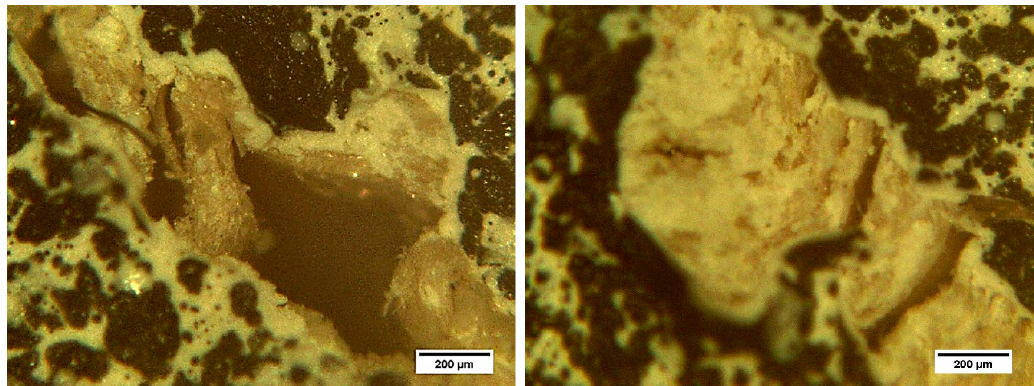
Figure 17. Microscopic appearance of the samples: ( a ) heterogeneity with associated porosity and ( b ) fiber arrangement.